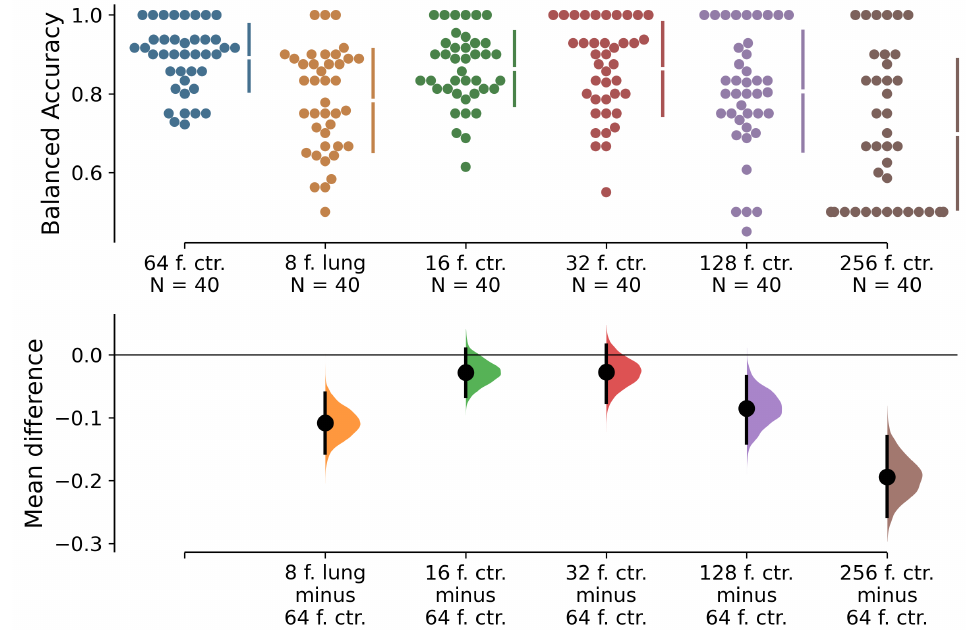
Figure 7. The mean difference of balanced accuracy for five classifiers with varying number of frames and the chosen slice selection method against the best performing classifiers (64 f. ctr.) are shown in the above Cumming estimation plot. The raw data is plotted on the upper axes. On the lower axes, mean differences are plotted as bootstrap sampling distributions. Each mean difference is depicted as a dot. Each 95% confidence interval is indicated by the ends of the vertical error bars. (f.: frames; ctr.: centroid slice selection; lung: lung slice